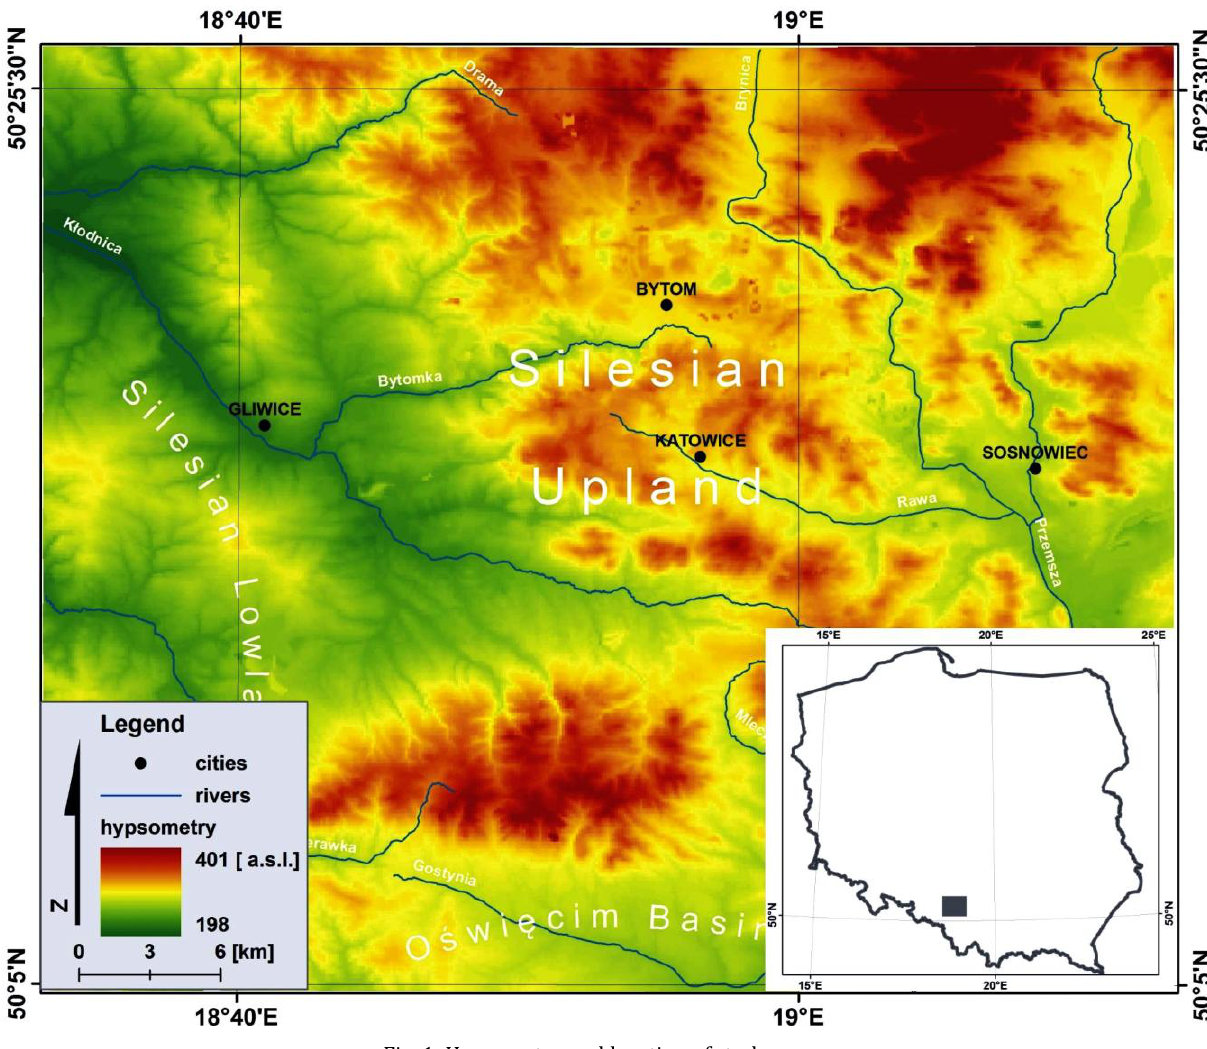
Fig. 1. Hypsometry and location of study